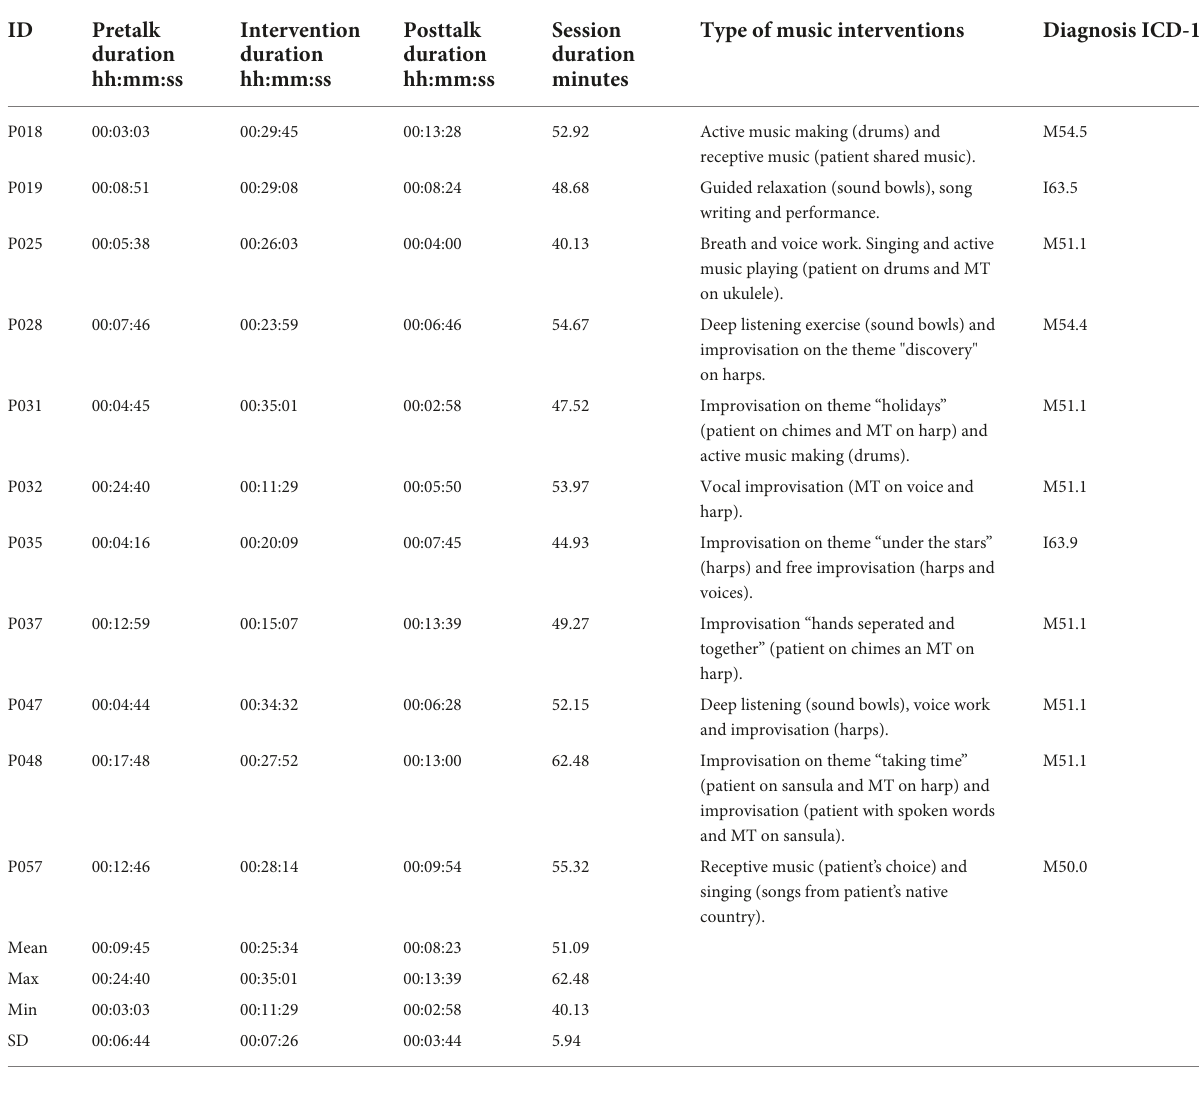
TABLE 1 Durations of pretalk, music intervention, posttalk, session, type of music intervention and diagnosis of participants.